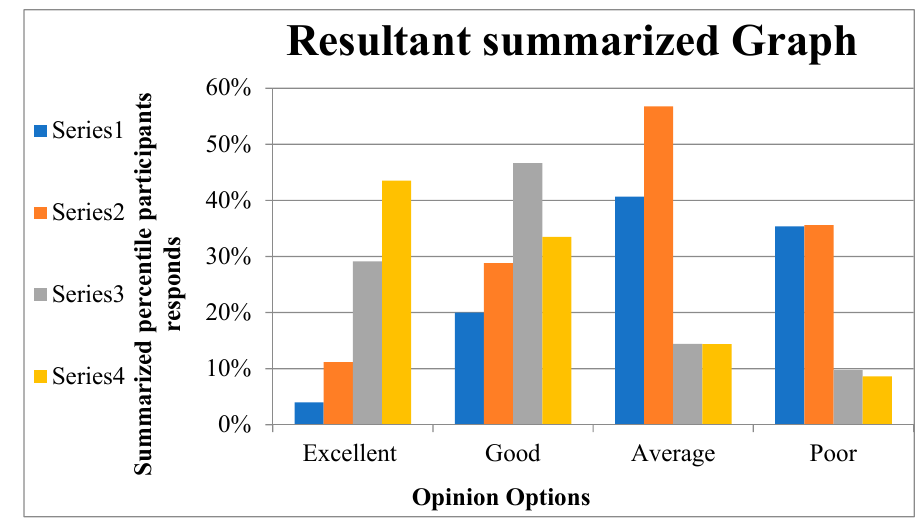
Figure 7. Summarized graph based on four categorical comparison tables.